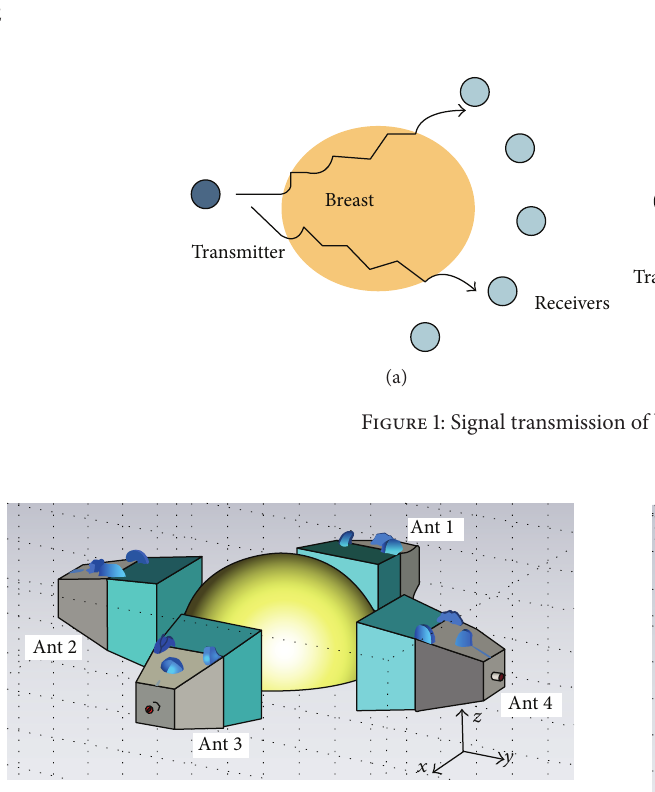
Figure 2: Simulated breast model constructed in simulation tool.